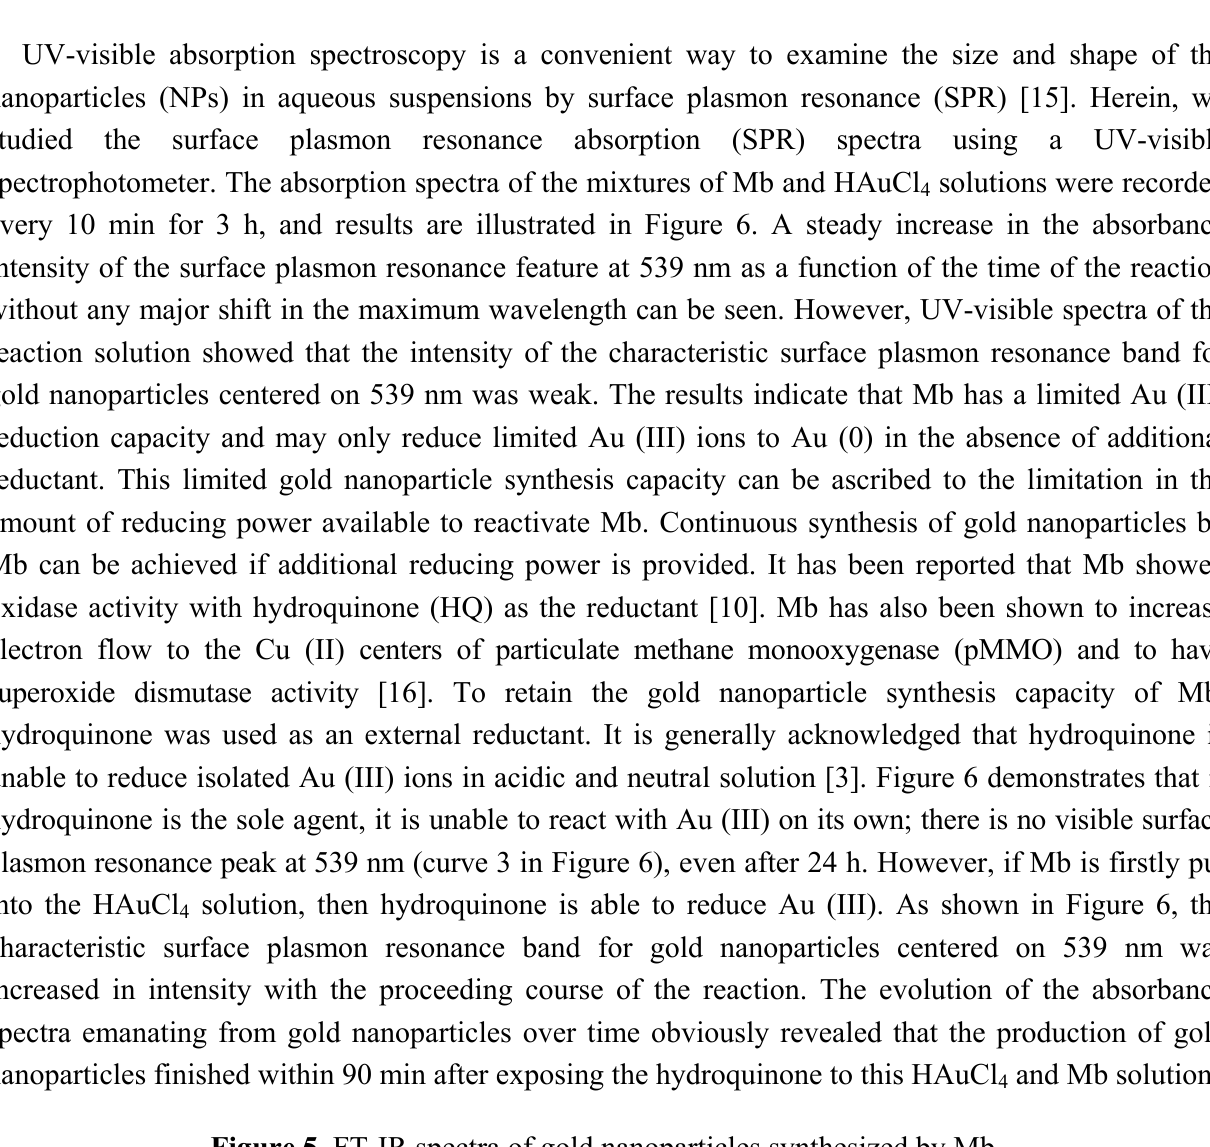
Figure 5. FT-IR spectra of gold nanoparticles synthesized by